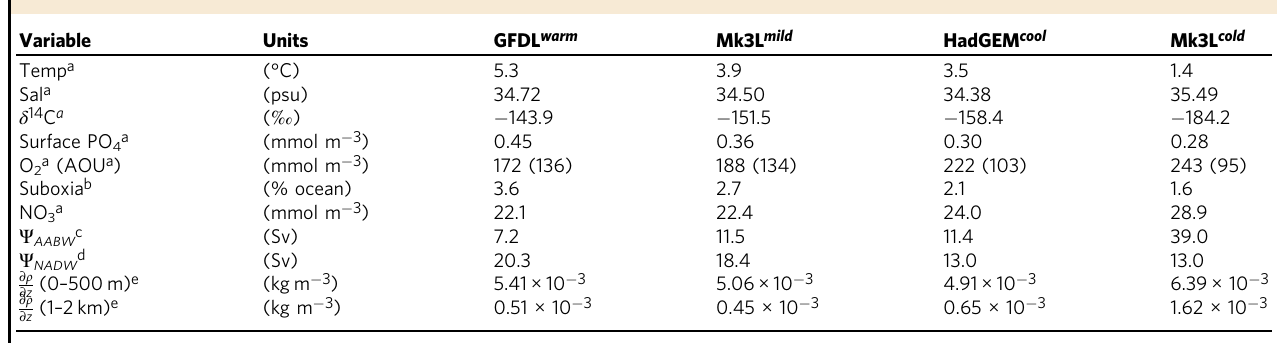
Table 1 Global properties of the four ocean states